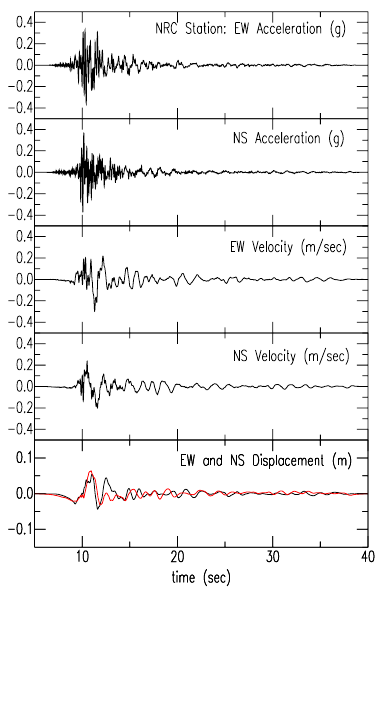
Figure 1. Time series of acceleration, velocity and dis- placement (black colors indicate EW component and red NS component) from the main shock of the Ama- trice seismic sequence, registered at stations: (a) NRC, (b)